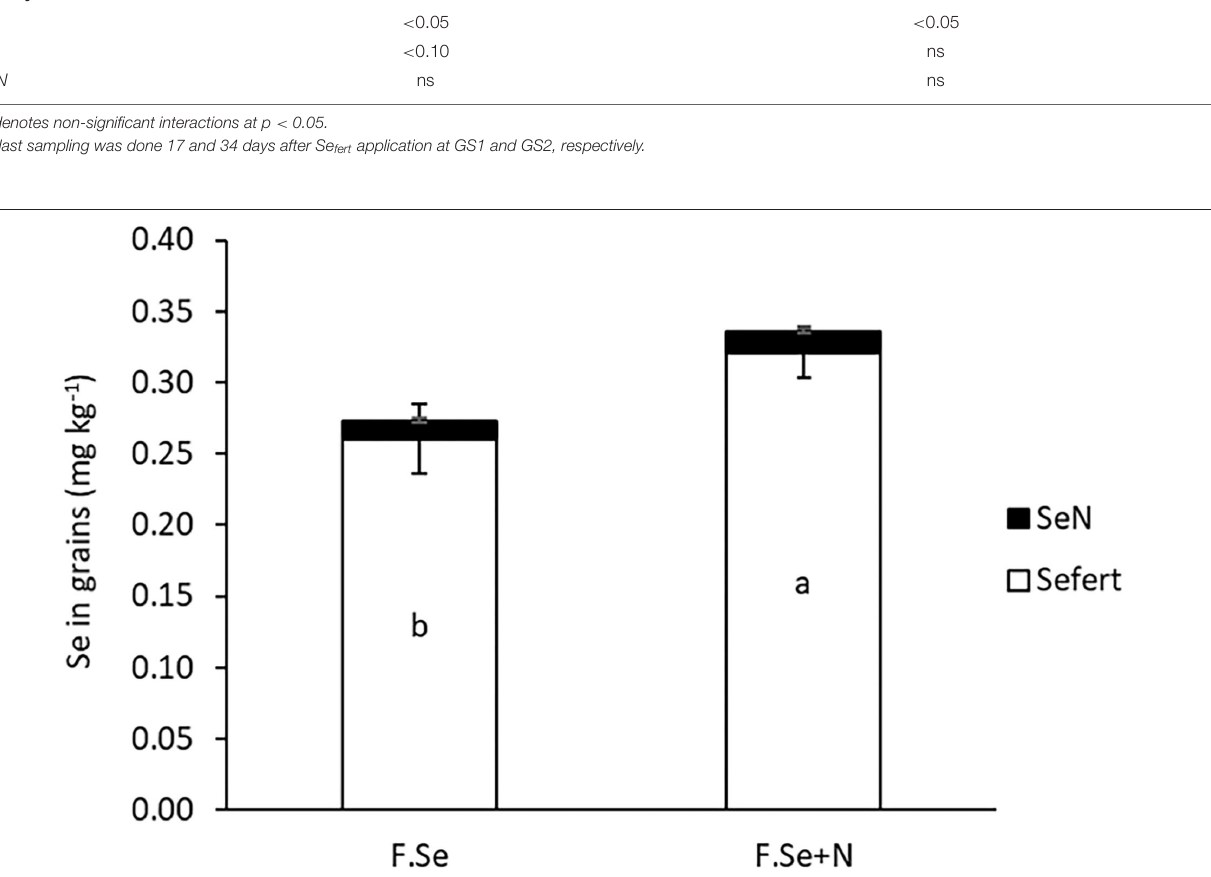
the total Se fert in the grain. A small amount of Se VI ( < 10% of the total Se fert ) was also detected in the grain, and no Se IV or SeCys was measured, irrespective of Se treatments ( Table 4 ). The SeMet concentration in grains (0.21 mg kg − 1 ), compared with